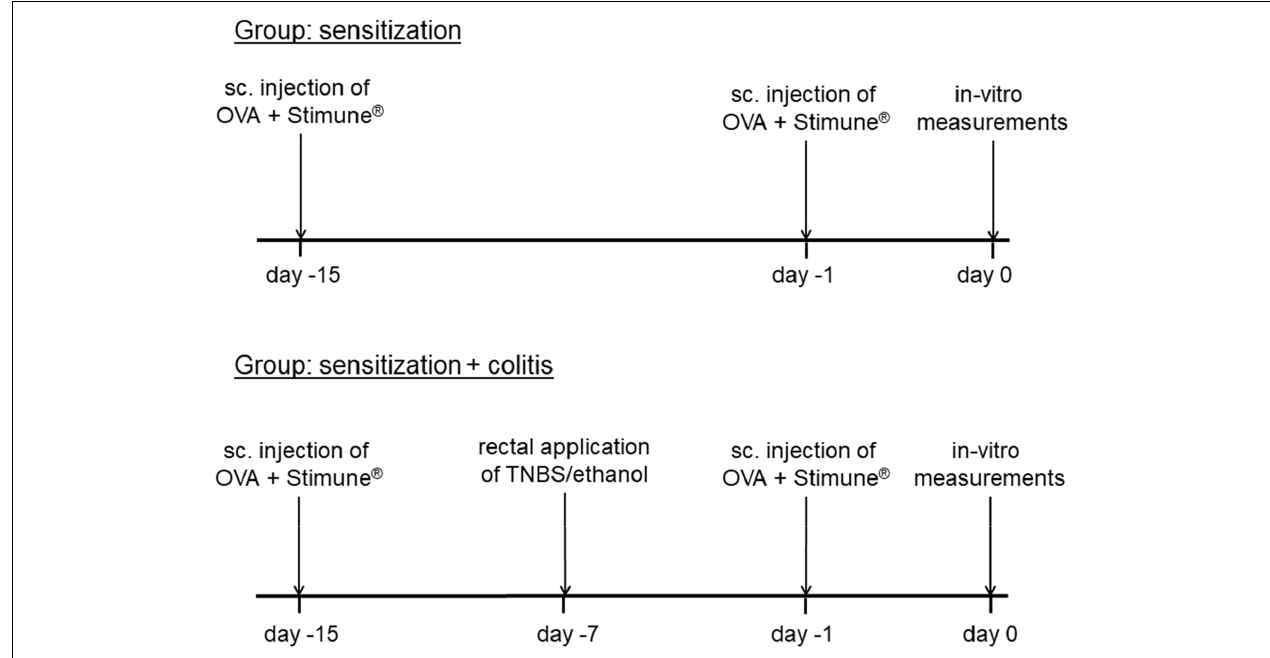
FIGURE 1 | Schematic time schedule of the colitis/sensitization experiment. Sc, subcutaneous, TNBS, 2,4,6-trinitrobenzenesulfonic acid dissolved in ethanol. All animals were sensitized by subcutaneous injection of ovalbumin (OVA) combined with Stimune R (cid:13) on day − 15 and − 1. In the second group (lower tracing), a mild colitis was induced additionally with TNBS/ethanol at day − 7 before the animals were euthanized.